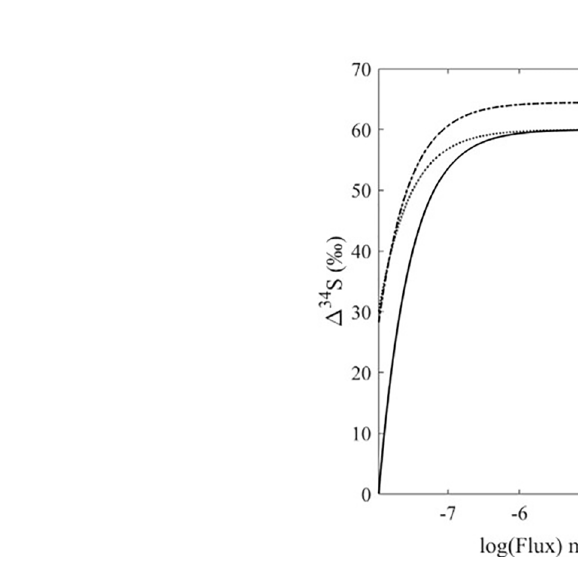
FIGURE 4 D 34 S fl ux for the global steady-state bioturbation models. The microbial sulfate reduction rate used for each model is SO4_sw-H2S_pw vs. advective 1 mol cm -2 day -1 . The sul fi de oxidation and disproportionation rates are half the sulfate reduction rate. All three models show that D 34 S SO4_sw- fl ux, where the fl ux is a proxy for the amount of bioturbation. H2S_pw increases with an increasing advective